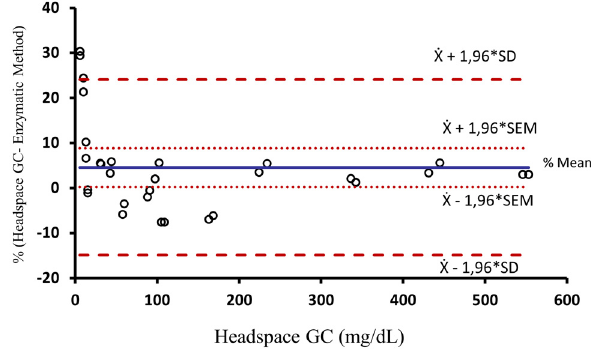
Figure 2: Bland – Altman plot of the enzymatic and HS/GC methods. SD, standard deviation; SEM, standard error of the mean; Ẋ , mean.